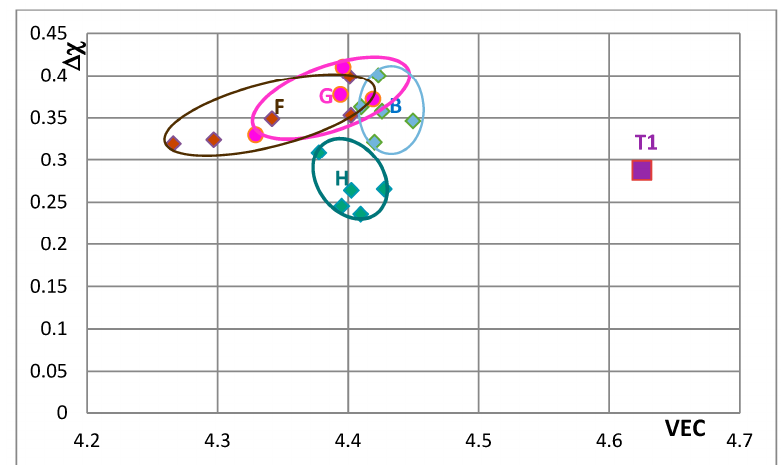
Figure 9. Δχ versus VEC map of unalloyed and alloyed Nb 5 Si 3 that shows the effect of the substitution of Nb by a transition metal or refractory metal addition, where T1 = Nb 5 Si 3 , area B = (Nb,Ti,Cr) 5 (Si,Al) 3 , area F = (Nb,Ti,Cr,Hf) 5 (Si,Al) 3 , area G = (Nb,Ti,Cr,Mo) 5 (Si,Al) 3 and area H = (Nb,Ti,Cr,Ta) 5 (Si,Al) 3 . The data is from KZ5 type alloys with nominal compositions Nb-24Ti-18Si-5Al-5Cr + 5X, where X = Hf, Mo, Ta. Average positions in areas B and F to H are indicated by data point closest to letter (see text).